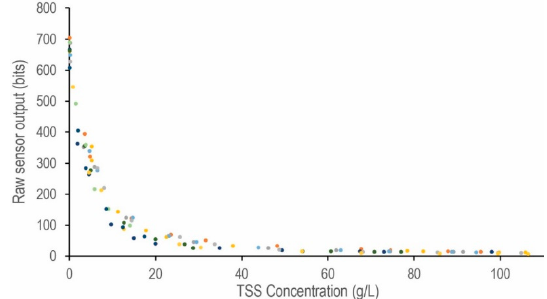
Figure A5. Sensor signal-to-noise ratio from increasing suspended sediment concentrations under controlled laboratory conditions [14].